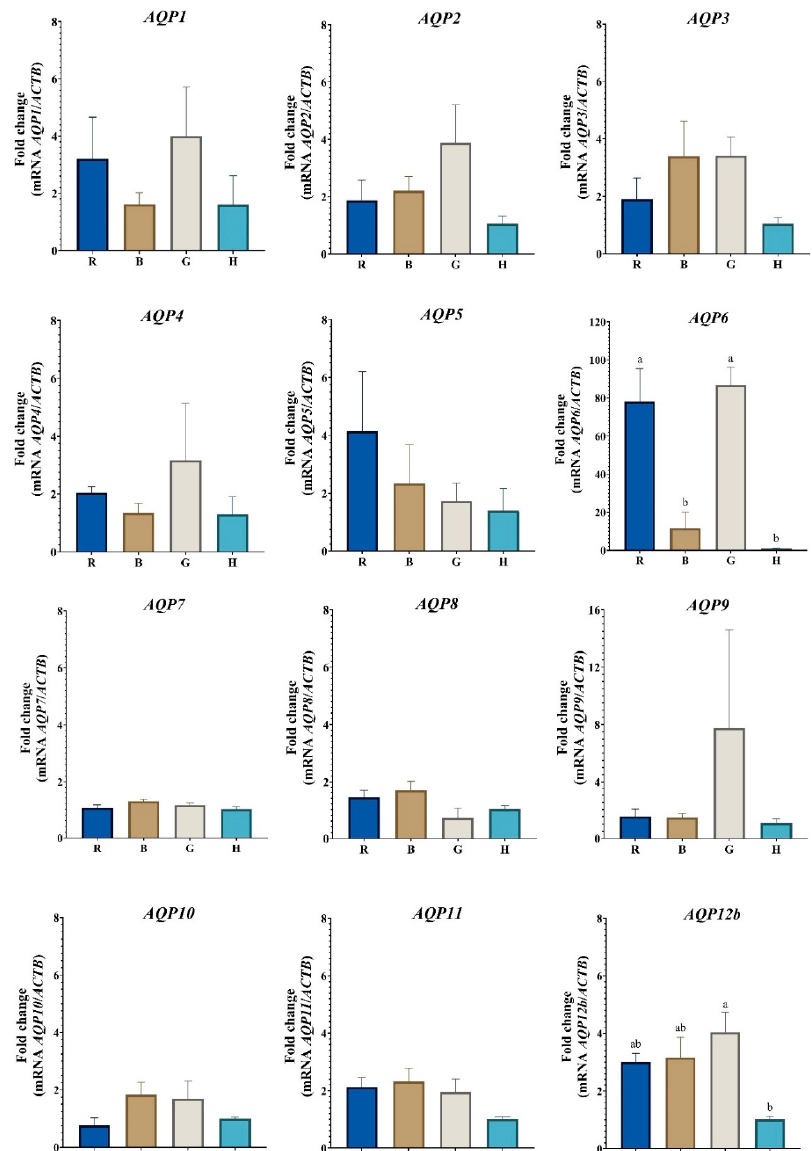
Figure 1. Relative expression of aquaporin gene transcripts in cattle COC from Romosinuano (R), Brahman (B), Gir (G), and Holstein (H) breeds. Different letters (a and b) denote statistical differences ( p < 0.05). AQPs names in italics denote its mRNA expression